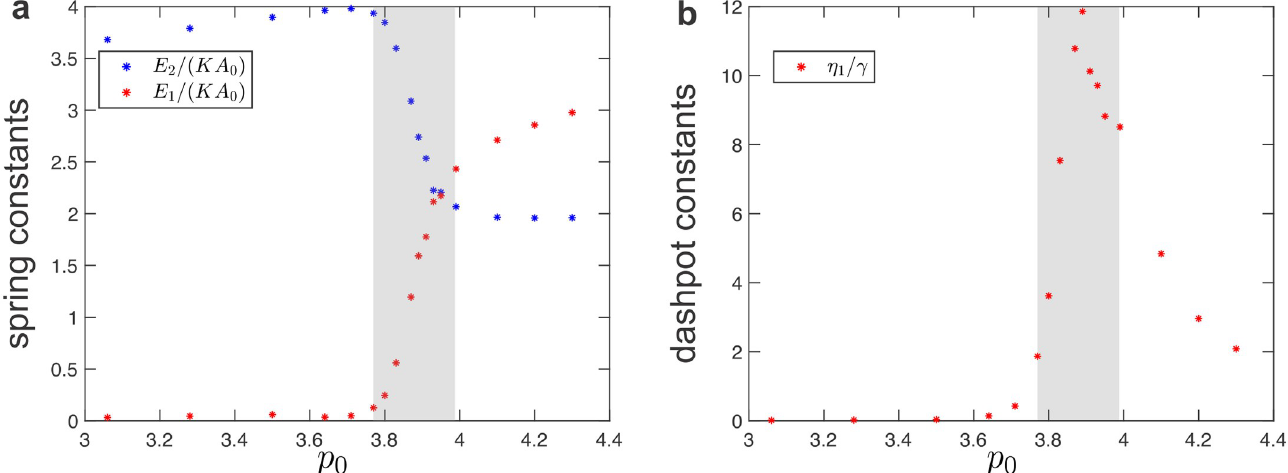
Fig 9. Fitted values of spring-dashpot models for disordered tilings under bulk deformation. (a) Elastic constants as a function of the target cell-shape parameter, p 0 . (b) Dashpot viscosity constant as a function of the target cell-shape parameter, p 0 . The shaded regions indicate the intermediate regime between the solid and fluid phases.